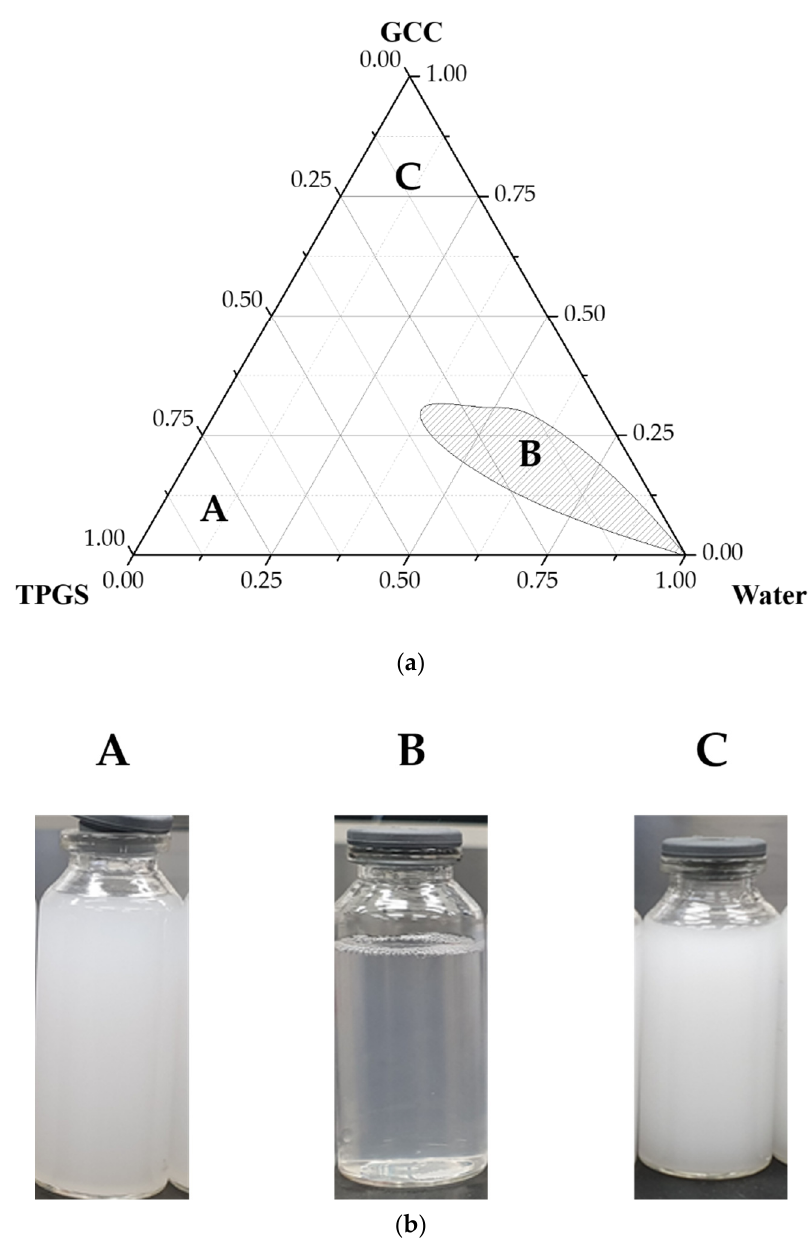
Figure 1. ( a ) Ternary phase diagram of emulsions with glyceryl caprylate/caprate, D- α tocopheryl polyethylene glycol 1000 succinate as oil component, and water, ( b ) image of the emulsions prepared by varying the composition ratio of TPGS and GCC.